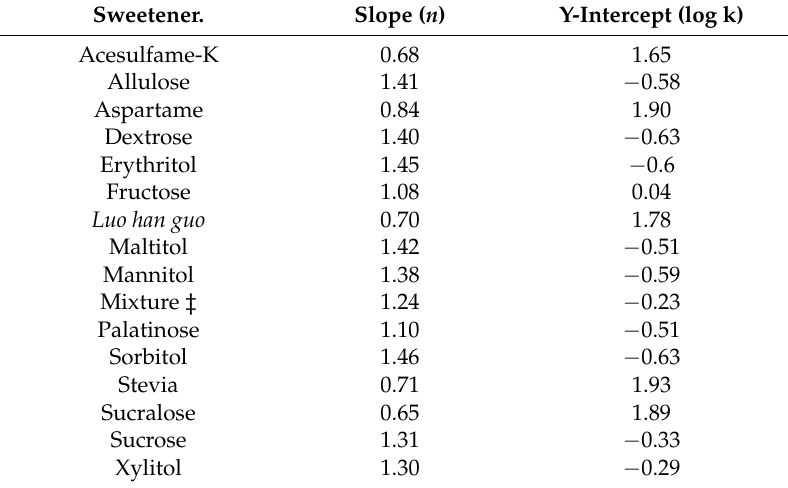
Figure 2. Log sweetness intensity vs. log concentration for 16 sweeteners. Table 3. Slope and y-intercept values of linear fit between log sweetness intensity and log concentration (% w/v ).